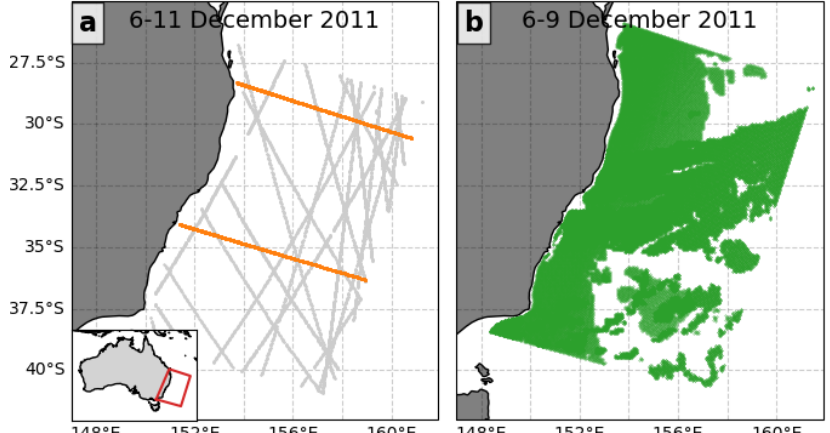
Figure B1. Example coverage of (a) along-track SSH (grey dots) and XBT (orange dots) over the period 6–11 December 2011 and (b) SST (green dots) over the period 6–9 December 2011. A shorter window is selected to show the typical spatial coverage of the SST, which, due to the high resolution and daily imaging, often covers the whole domain. Gaps in SST coverage are usually due to low surface winds or high cloudiness. These gaps are simulated using thresholds of 2ms − 1 and 0.75 (for low wind and cloudiness, respectively) and are applied to daily fields from BARRA-R. Methods for masking and preparation of the SST and other observations are given in detail in Gwyther et al.